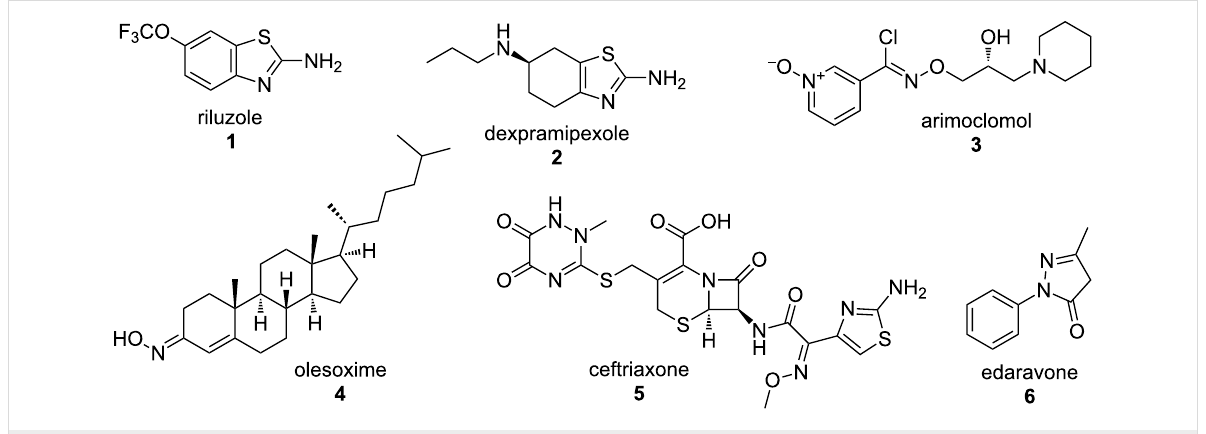
Figure 1: FDA-approved riluzole ( 1 ) and other ALS drugs currently in phase III clinical trials ( 2 – 6